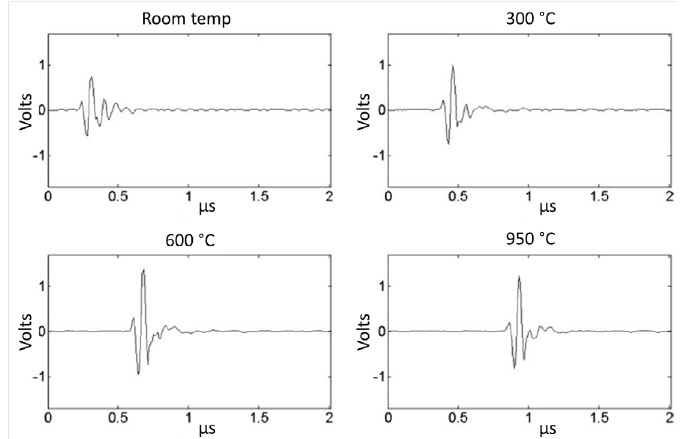
Figure 15. Waveforms obtained from in situ test at temperatures up to 950 °C for the YCOB transducer [85] (copyright 2013 by the